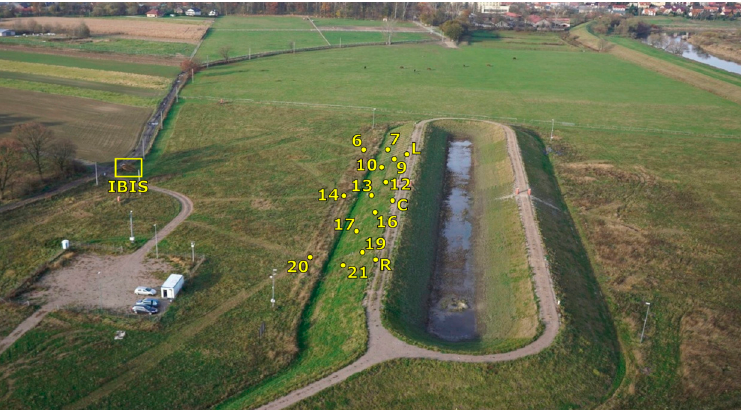
Figure 1. Example of a moderate resolution imaging spectroradiometer (MODIS) scene from the middle-east region in Europe. Pixel ground size is 6 km.